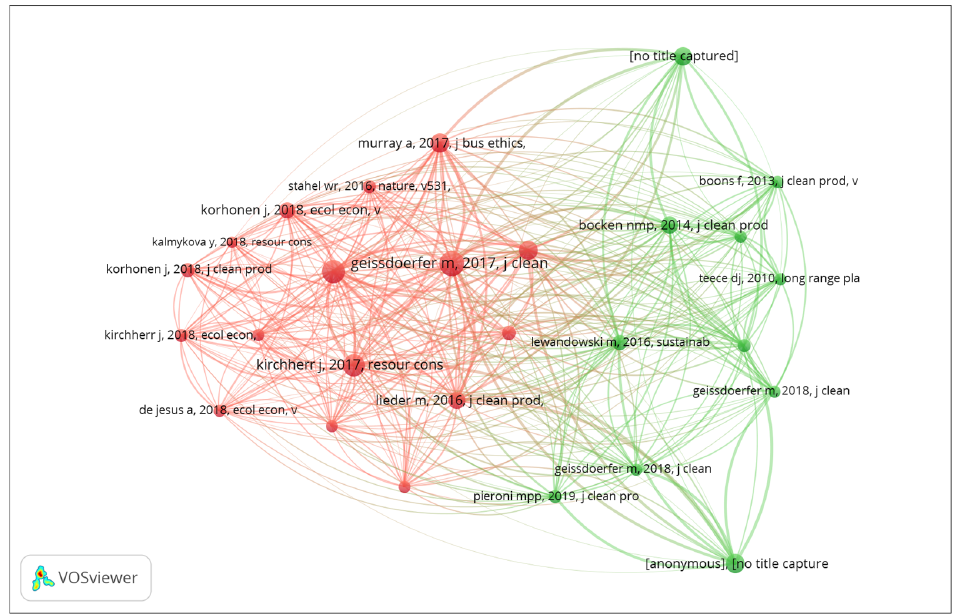
Figure 8. VOSviewer diagram containing the most cited papers with at least 25 citations, for the couple: social innovation and circular* .